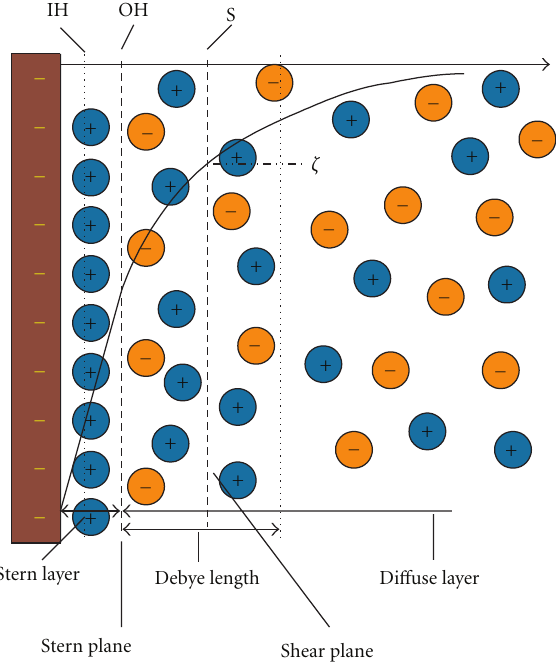
Figure 1: Electric double-layer according to the Stern model. The inner and outer Helmholtz planes are indicated as IH and OH, respectively. The slipping plane is denoted by S and its charge is characterized by the ζ -potential (modified from